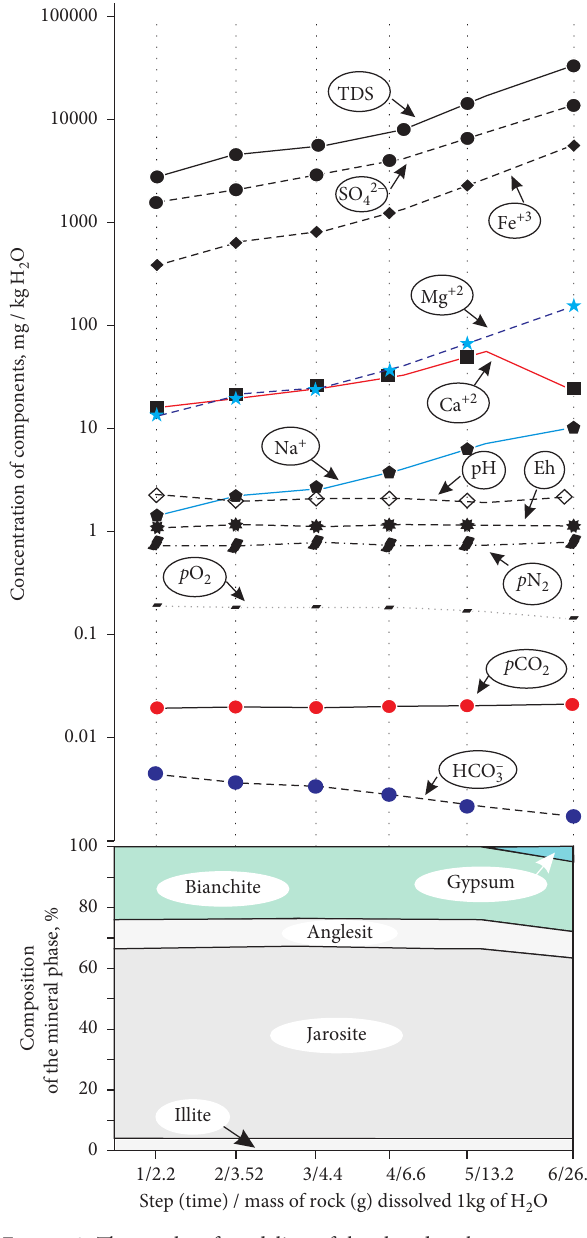
Figure 3: The results of modeling of the closed rock-water system evolution (CO 2 � 0.01kg/L per 1kg of H 2 O; atmospheric gas � 0.3 kg/L per 1kg of H 2